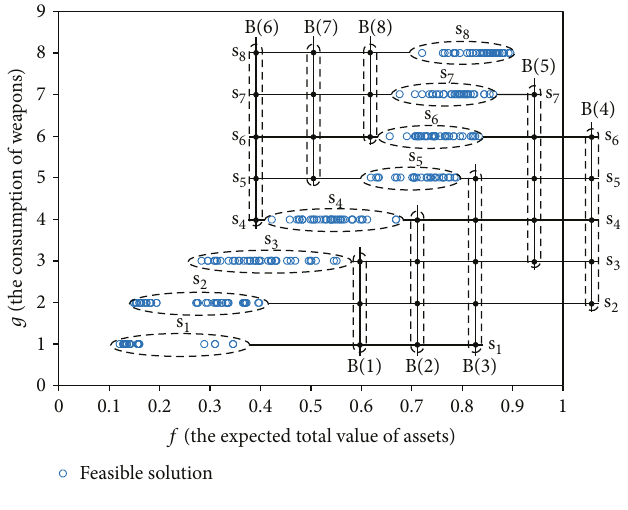
Figure 5: Illustration of the proposed mating restriction.